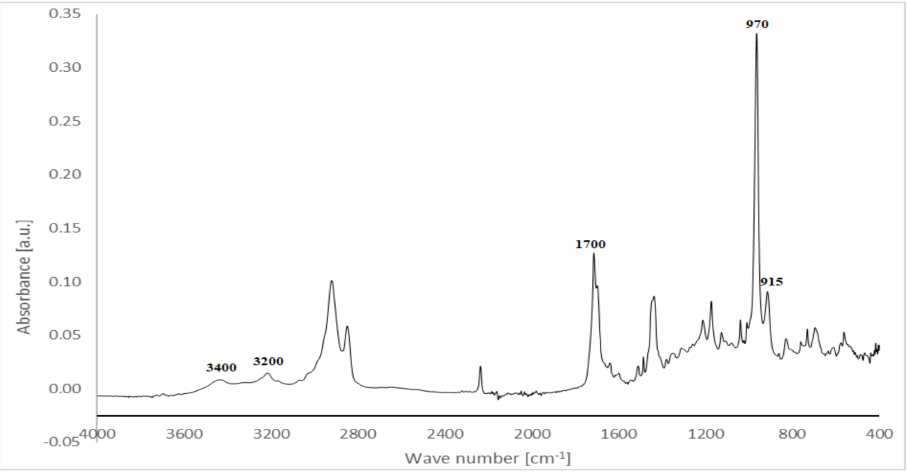
Figure 10. FTIR spectrum illustrating the way of crosslinking of XNBR with PO resin